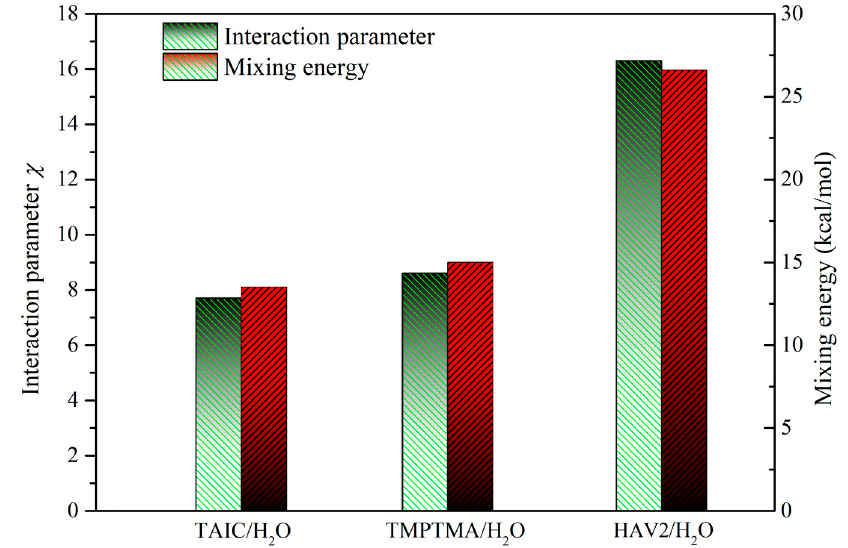
Figure 5. Mixing energies and interaction parameters of the binary systems comprising molecules of water and auxiliary crosslinker at room